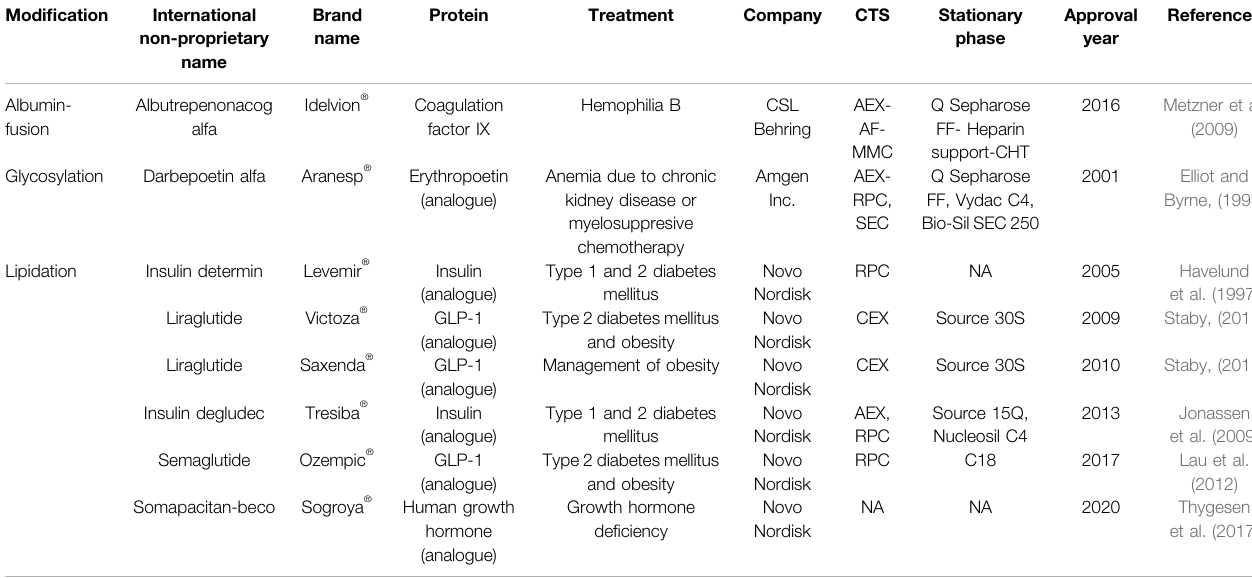
TABLE 5 | Approved proteins with other modi fi cations: albumin-fusion, glycosylation, and lipidation.